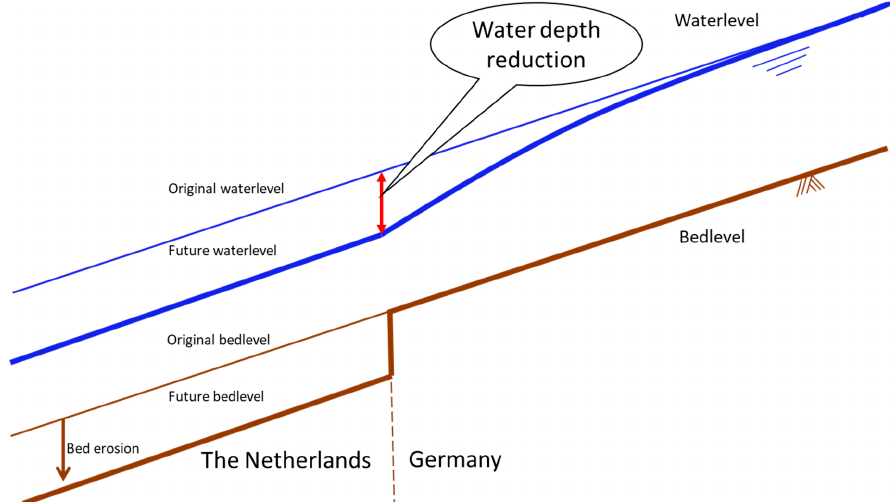
Figure 5. Reduction in water depth at the border due to downstream bed erosion.